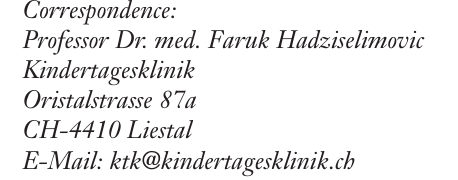
ing-Bablok regres- sion line: dotted